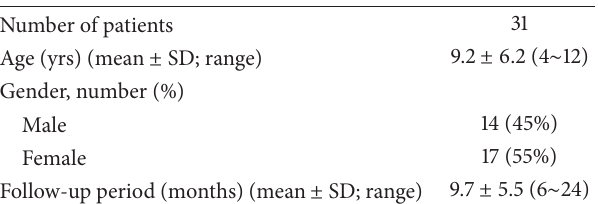
Figure1:Slantedlateralrectusmusclerecession. Theupperpolewas recessed according to the distance exodeviation and the lower pole was recessed according to the near exodeviation. Table 1: Preoperative patient